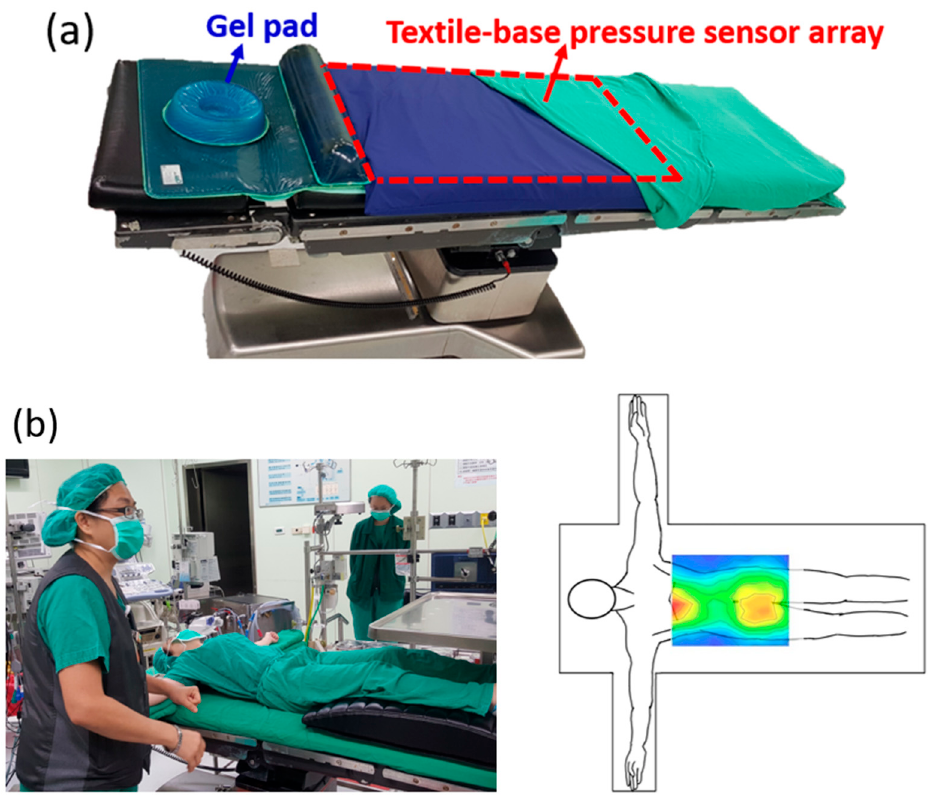
Figure 2. Picture of the real situation for the setup in the operation room: ( a ) A flexible pressure mattress on an operation bed with ( b ) a nurse lying on it.